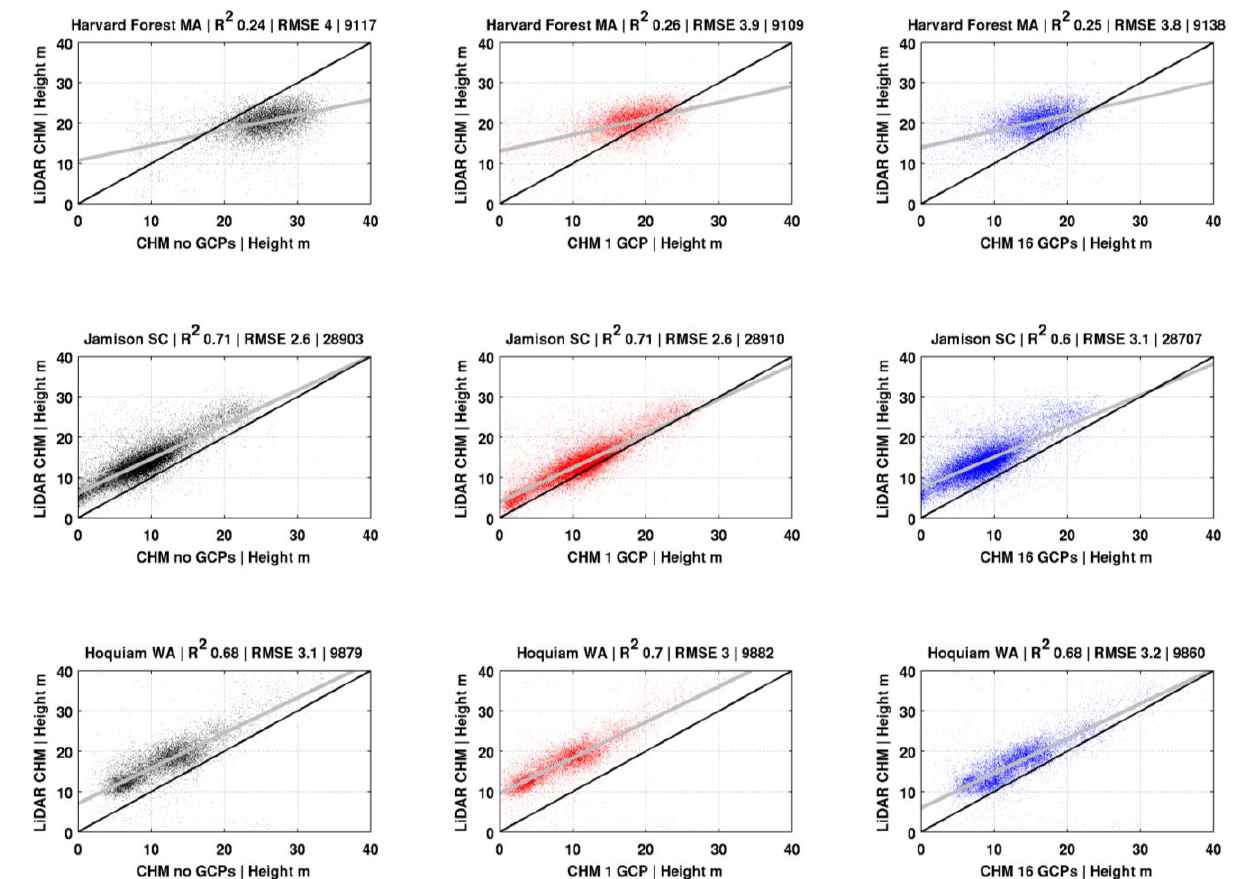
Figure 6. CHM scatter plots of three study regions with total number of random samples indicated in plot title. Values not meeting valid criteria listed in Table 2 were excluded from analysis. The solid black line indicates a one-to-one relationship and the solid gray line indicates a least squares linear fit. Colors from left to right indicate no GCPs in black, one GCP in red, and 16 GCPs in